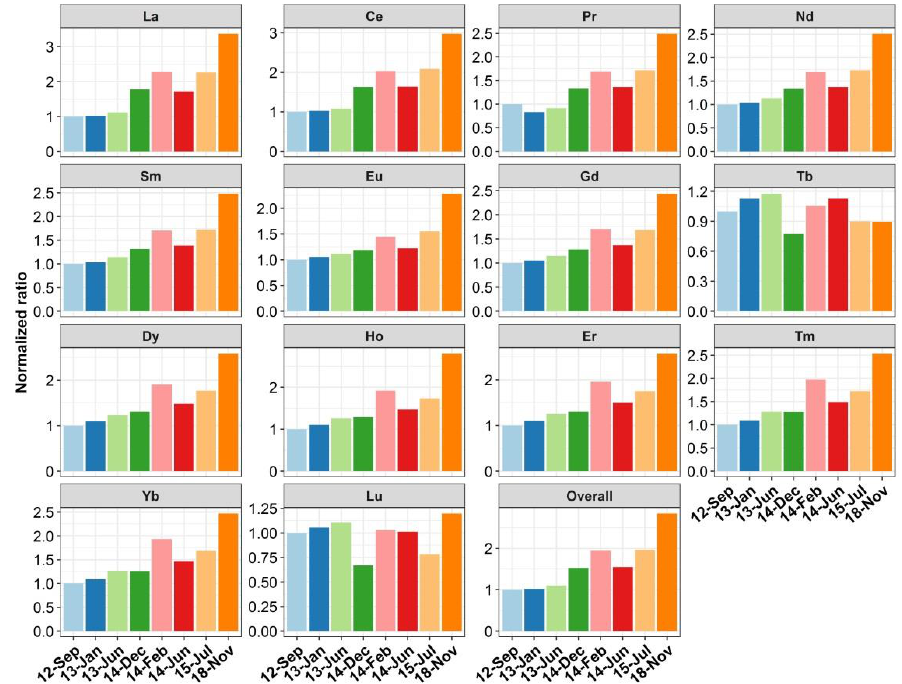
Figure 4. Temporal variations of REEs in JRE sediments. The concentrations of REEs from different sampling times were normalized with those from the first sampling time.